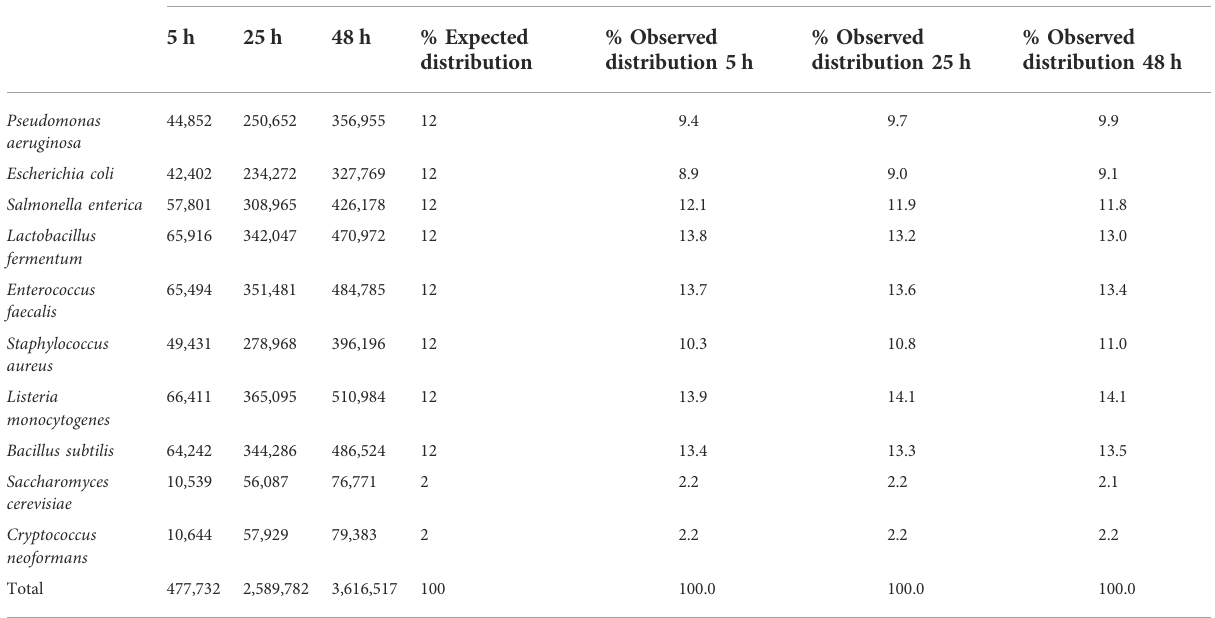
TABLE 1 Summary of the WIMP output for the nanopore sequencing of the ZymoBIOMICS microbial community DNA standard using the RAD004 kit atdifferent timeintervals(5,24and48 h).Totalnumberofreadsidenti fi edforeachmicroorganism andtheirexpectedpercentagedistributionin the